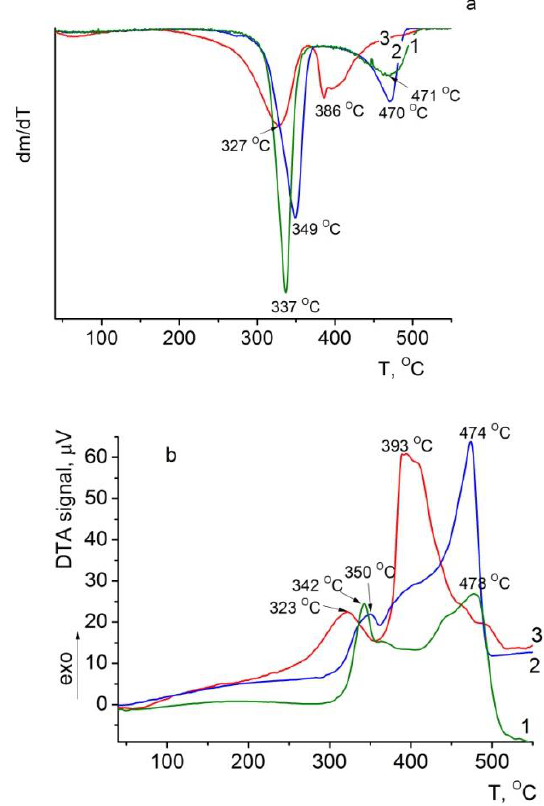
Figure 8. DTG ( a ) and DTA ( b ) curves of (1) BC, (2) BC – ALG – CS, and (3) BC – ALG(CeONP) – CS